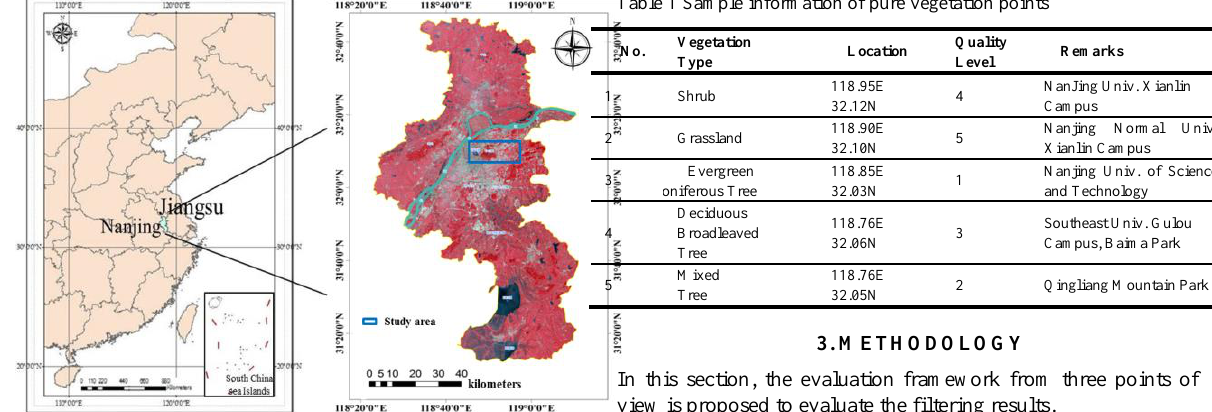
Table 1 Sample information of pure vegetation